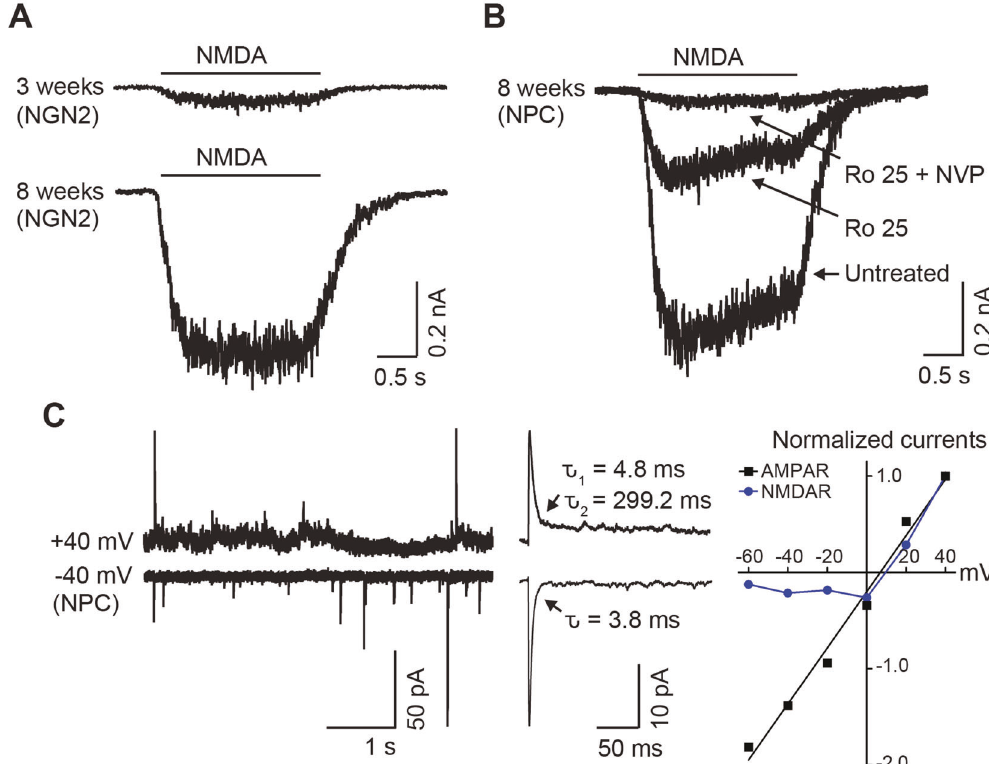
Fig. 2 NMDAR currents in human iPSC-derived neurons. A Traces displaying NMDA-evoked currents in 3- and 8-week-old human NGN2 iPSC-derived neurons, which were differentiated with a rapid single-step NGN2 induction. B A representative trace shows NMDA-evoked currents in a human iPSC-derived neuron, which was differentiated through an NPC stage in 8-week-old culture, and the effects of Ro 25-6981 (1 µM), a selective antagonist of GluN2B-containing NMDARs and NVP-AAM077 (0.4 µM), an antagonist of GluN2A-containing NMDARs. C Left, Traces showing mEPSCs recorded at the membrane potentials of − 40 mV (bottom) and + 40 mV (upper) in presence of extracellular Mg 2 + at 2 mM in a human iPSC-derived neuron, which was differentiated through an NPC stage in about 4-month-old culture. Middle, Averaged mEPSCs at − 40 mV and + 40 mV in this cell. Right, A plot depicting the current-voltage relationship of AMPA-mEPSCs and NMDAR-mEPSCs in this